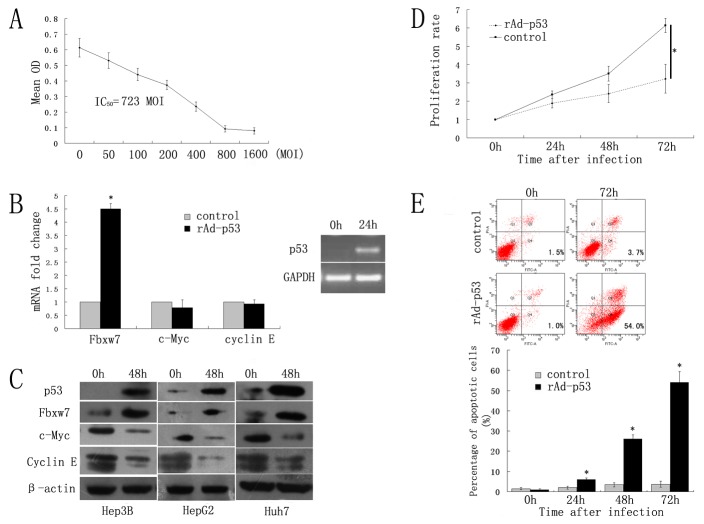
rAd-p53 induces apoptosis in HCC cell lines with increased Fbxw7 and decreased c-Myc and Cyclin E.A) MTT activity was measured after infecting Hep3B cells with rAd-p53 in an MOI gradient to determine their IC50 after 48 h. Mean OD values were used to calculate the IC50 via the modified Kou-type method: lgIC50 = Xm-I (P-(3-Pm-Pn)/4), in which Xm: lg maximum dose; I: lg (maximum dose/ adjacent dose); P: sum of positive response rate; Pm: the largest positive response rate; Pn: the smallest positive response rate. B) Over-expression of p53 24 h after infection as confirmed by RT-PCR. Quantification of RT-PCR for p53 and Fbxw7 indicated elevated mRNA levels for rAd-p53 infected Hep3B cells, whereas c-Myc and Cyclin E levels were not significantly decreased. C) Protein expression of p53 and Fbxw7 was enhanced, while c-Myc and Cyclin E expression was suppressed by rAd-p53 in Hep3B, HepG2 and Huh7 cells, as confirmed by Western blot analysis. β-actin served as loading control. D) Hep3B proliferation rate assessed by MTT assay was significantly lower in rAd-p53 infected cells compared to control cells. E) Quantification of apoptotic cell population (AnnexinV positive/ PI negative) by flow cytometry. rAd-P53 infected Hep3B cells were composed of a larger subset of apoptotic cells after 72 hours of infection compared to control. Values are depicted as mean±standard error, n=3. *P<0.05 vs control.